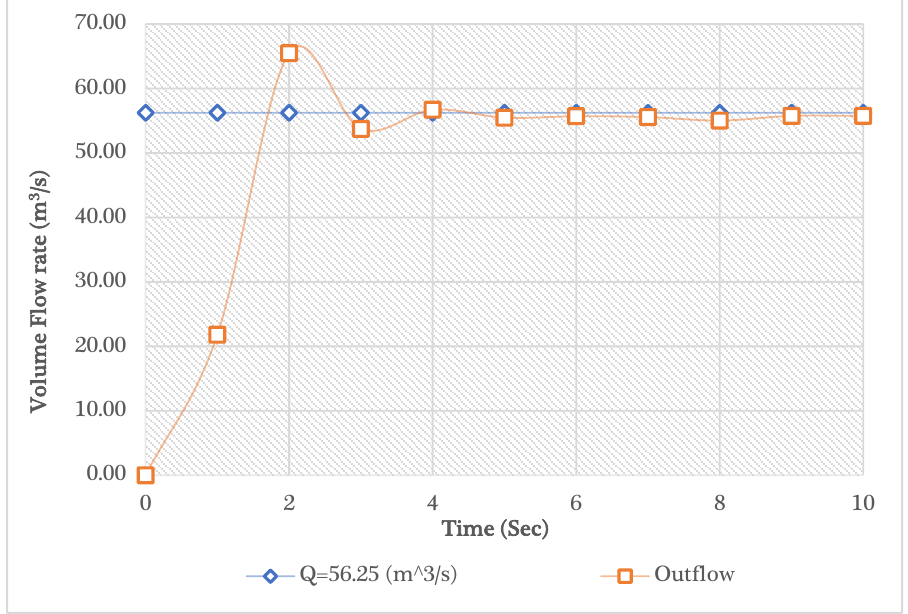
Figure 5. Comparison of the flow rates between inflow and outflow from Flow3D numerical model.